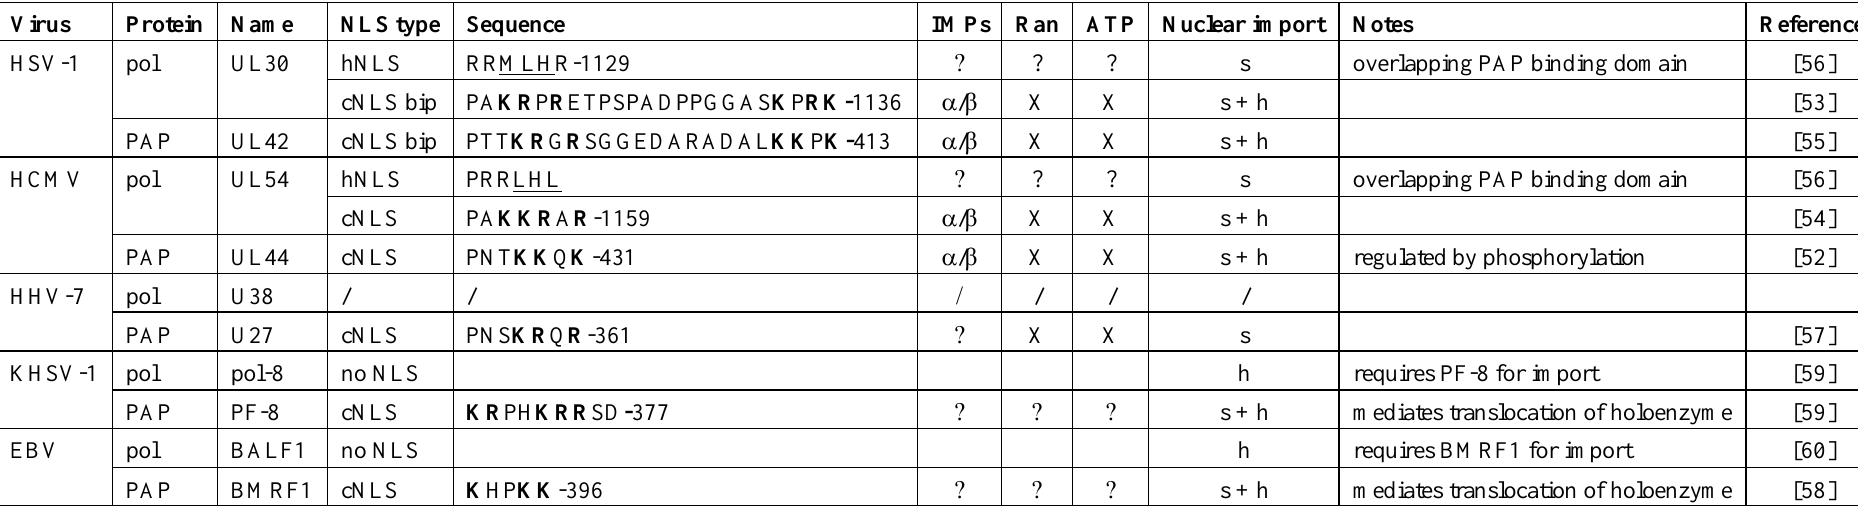
Table 2. NLSs identified on Herpesviral DNA polymerase subunits and nuclear import molecular mechanisms. Pol, DNA polymerase catalytic subunit; PAP, DNA polymerase processivity factor; hNLS, hydrophobic NLS; cNLS, classical NLS. The single letter amino acid code is used; hydrophobic residues in hNLS are underlined , whereas basic residues in cNLSs are in boldface . s indicates the ability of the NLS to function when the subunit is uncomplexed; h indicates the ability of the signal to function once the holoenzyme is assembled. In the column “Ran” the sensitivity of nuclear transport to overexpression of the transdominant negative RanQ69L is reported; in the column “ATP”, sensitivity to depletion of intracellular ATP levels; X, sensitivity; ?,